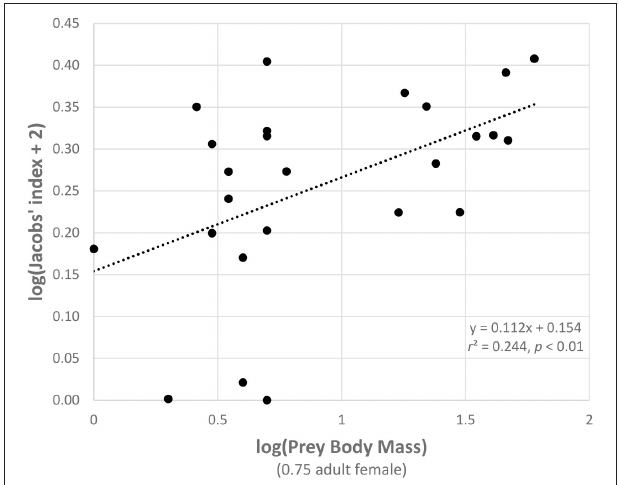
FIGURE 6 | Relationship between the Jacobs’ index of each prey species with three or more records and prey body mass (both log transformed).